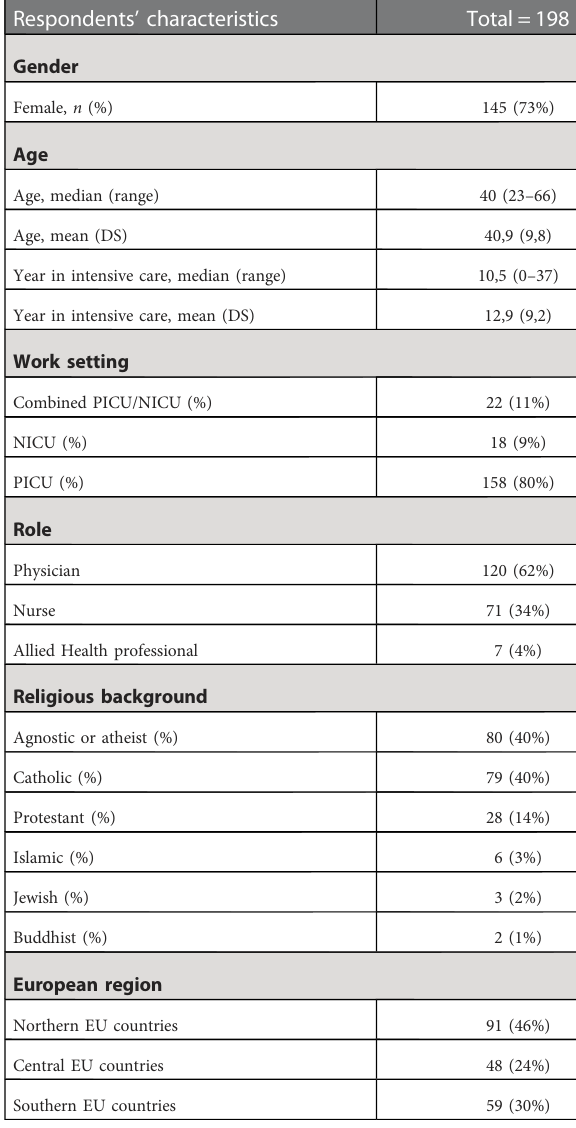
TABLE 1 Demographic characteristics of the cohort of European